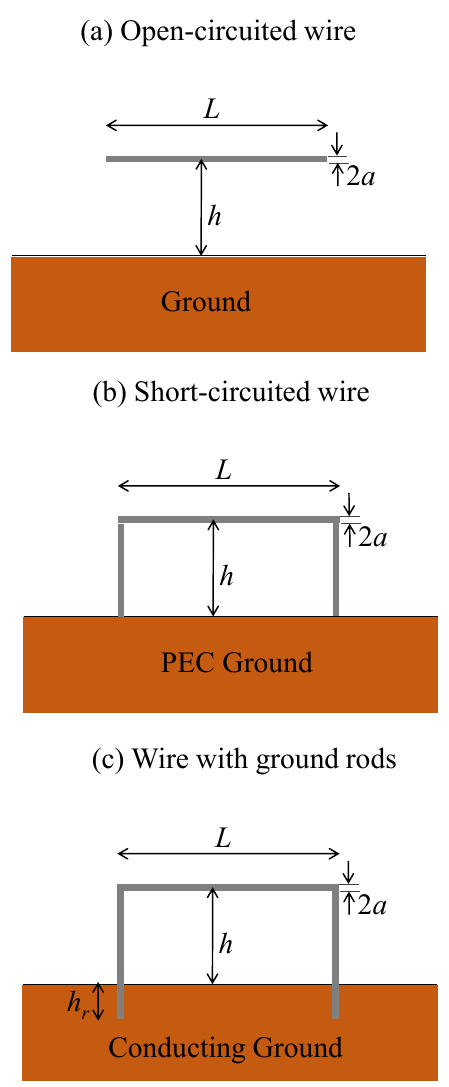
Figure 1: Geometry of a finite wire with length L and radius a above ground for the cases of (a) open-open, (b) short-short, and (c) grounded rods. The down conductors have the same radius as the aerial